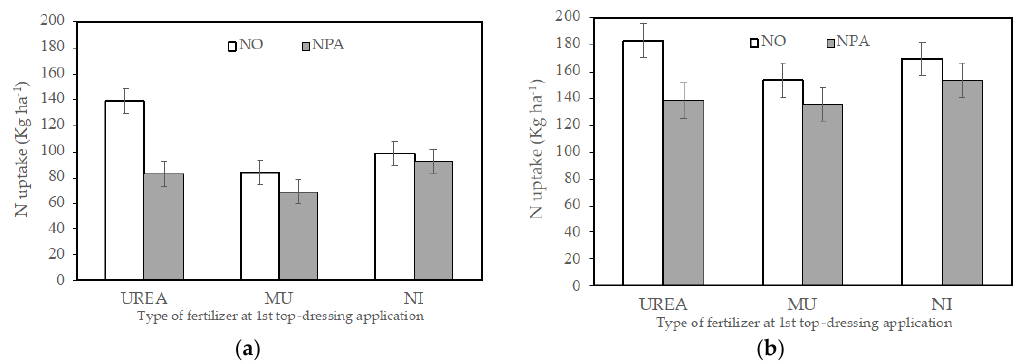
Figure 4. N uptake of durum wheat as affected by N source × N rate interaction at the two locations: ( a ) Pisa; ( b ) Arezzo. Vertical bars represent LSD ( p = 0.05).